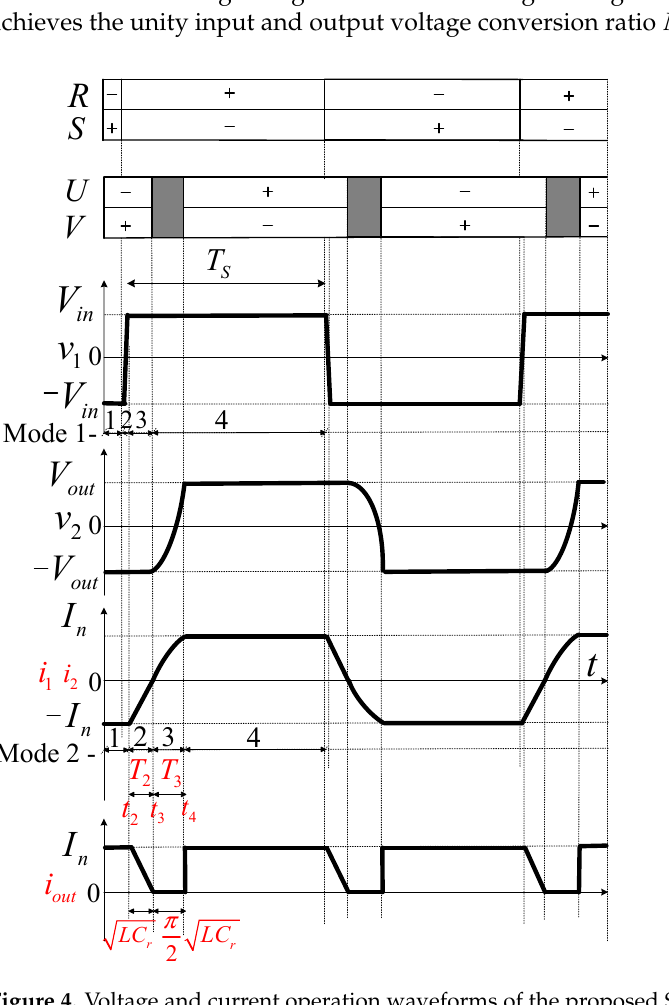
Figure 4. Voltage and current operation waveforms of the proposed SR–SAB DC–DC converter. The primary H-bridge converter produces the rectangular AC voltage (cid:1874) (cid:2869) with the amplitude (cid:1848) (cid:3036)(cid:3041) and switching frequency (cid:1858) (cid:3046) (= 1 2(cid:1846) (cid:3046) ) ⁄ by alternately switching the